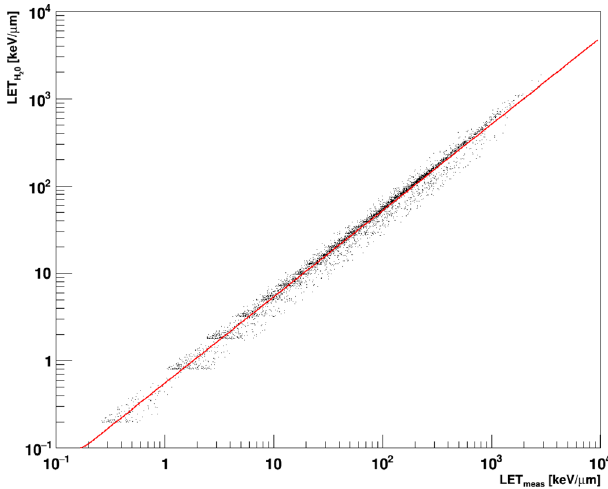
Fig. 4. Scatter plot of LET H as calculated with G4EMCalculator 2 O and of LET meas for all ions. A reduced number of points for each sample is included to improve visibility. The fi tted line is computed using the full